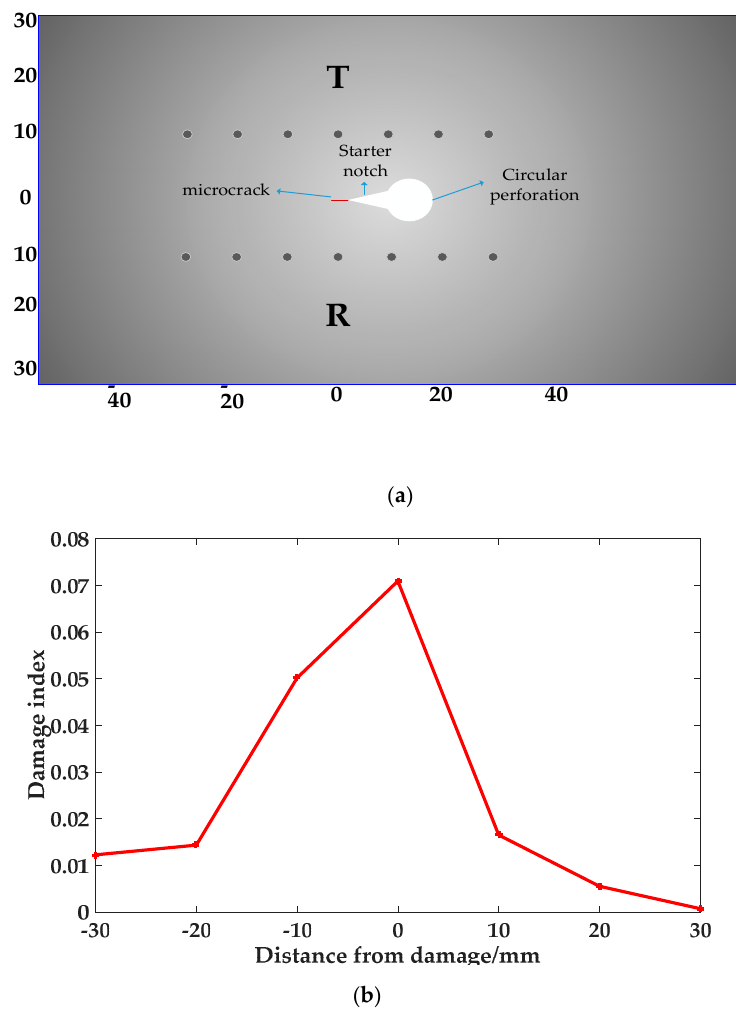
Figure 5. Research on the relative nonlinear coefficient: ( a ) The probe layout for looking for the law; ( b ) the distribution law of β .